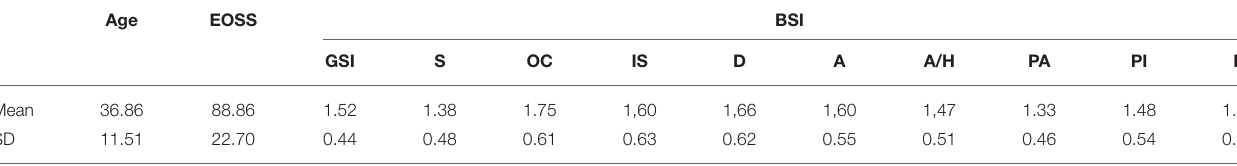
TABLE 1 | Means and standard deviations of age and participant scores on the